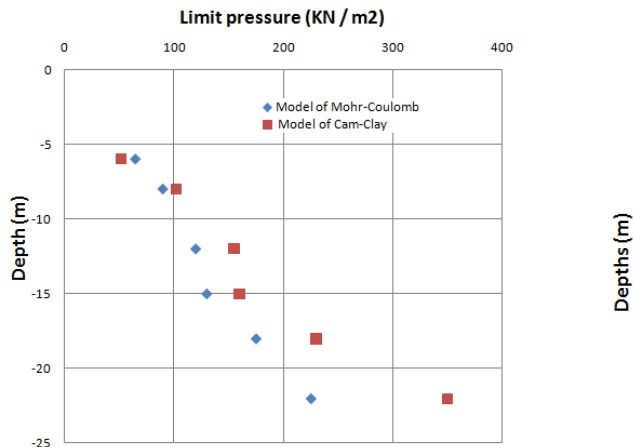
Fig.4. Pressurometric curves -Sloping massif.